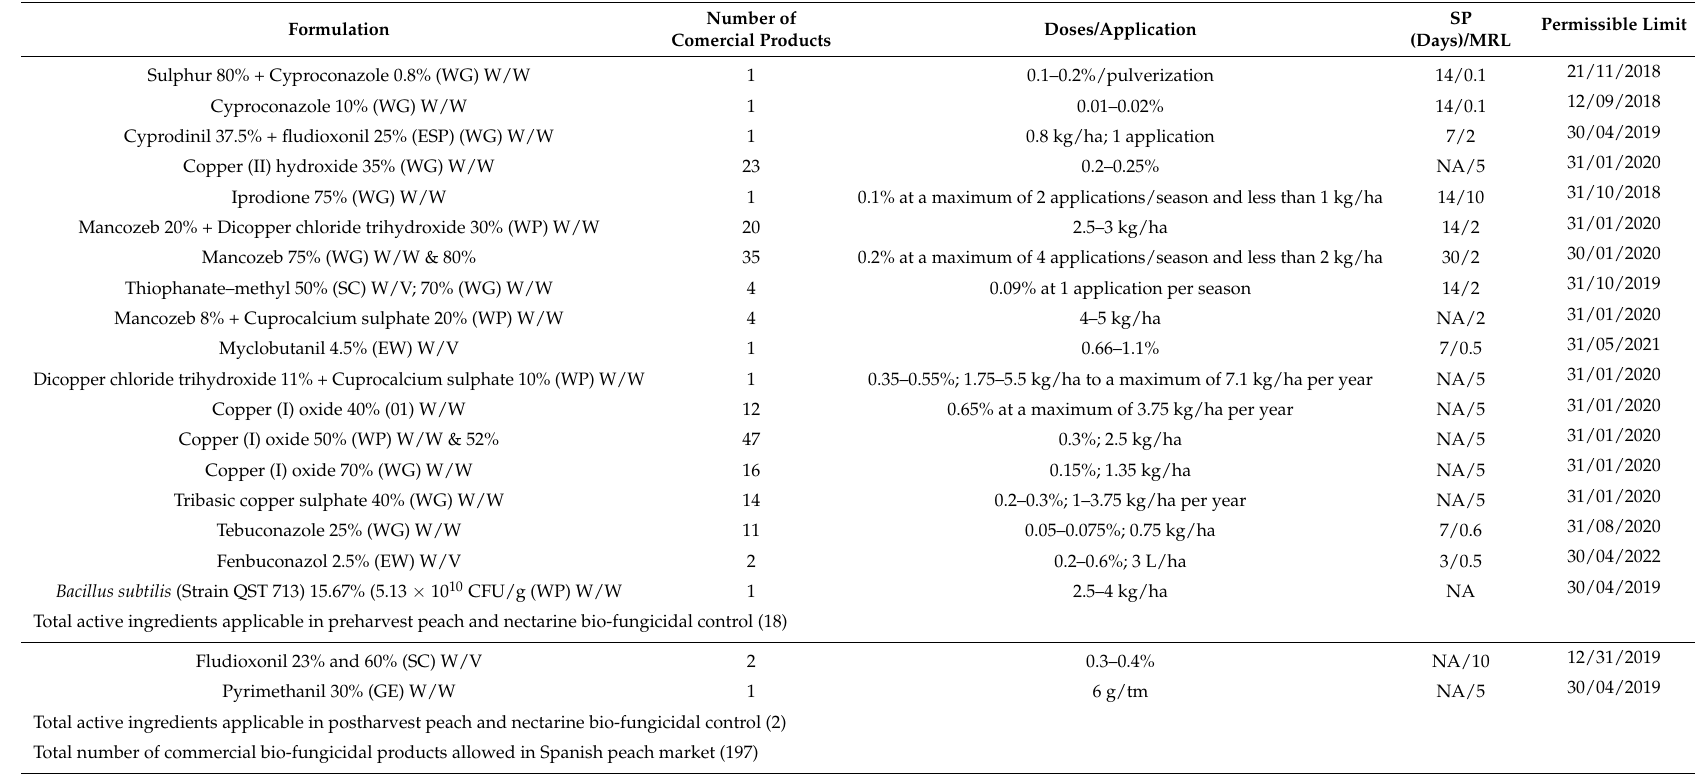
Table 4. Chemical and biological formulations used against Monilinia in stone fruit production in Spain.